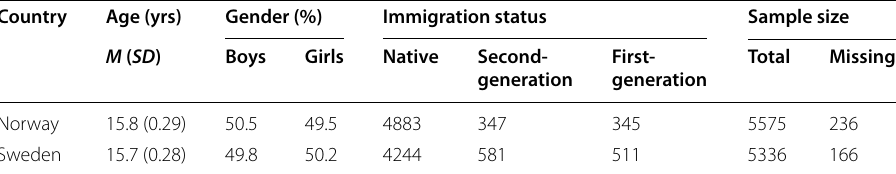
The samples are based on the available HOMEPOS data